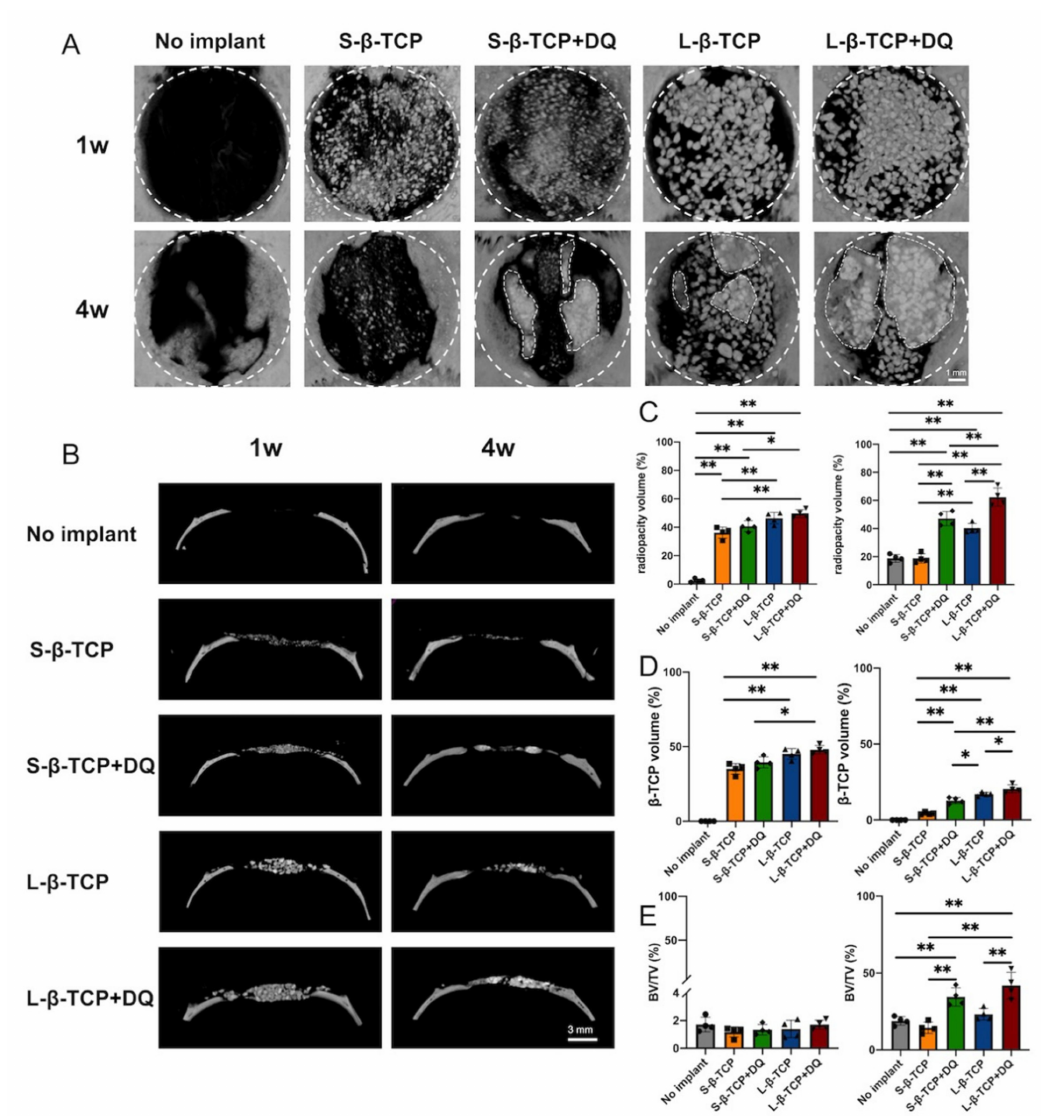
Figure 9. Morphometric analysis of new bone formation and residual beta-tricalcium phosphate ( β -TCP) using micro- computed tomography ( µ CT). ( A ) Vertical microcomputed tomography. The inner part of bold broken lines represents bone defect. The inner part of thin broken lines represents the granules fused with the newly formed bone. ( B ) Lateral microcomputed tomography; ( C ) radiopacity volume in defects using µ CT analysis; ( D ) volume of β -TCP residual using µ CT analysis; ( E ) bone morphometry of newly formed bone by removing of β -TCP. BV: Bone volume; TV: Total volume. Mean with SD ( n = 4). * p < 0.05, ** p < 0.01, one-way ANOVA analysis with Tukey–Kramer method as post hoc